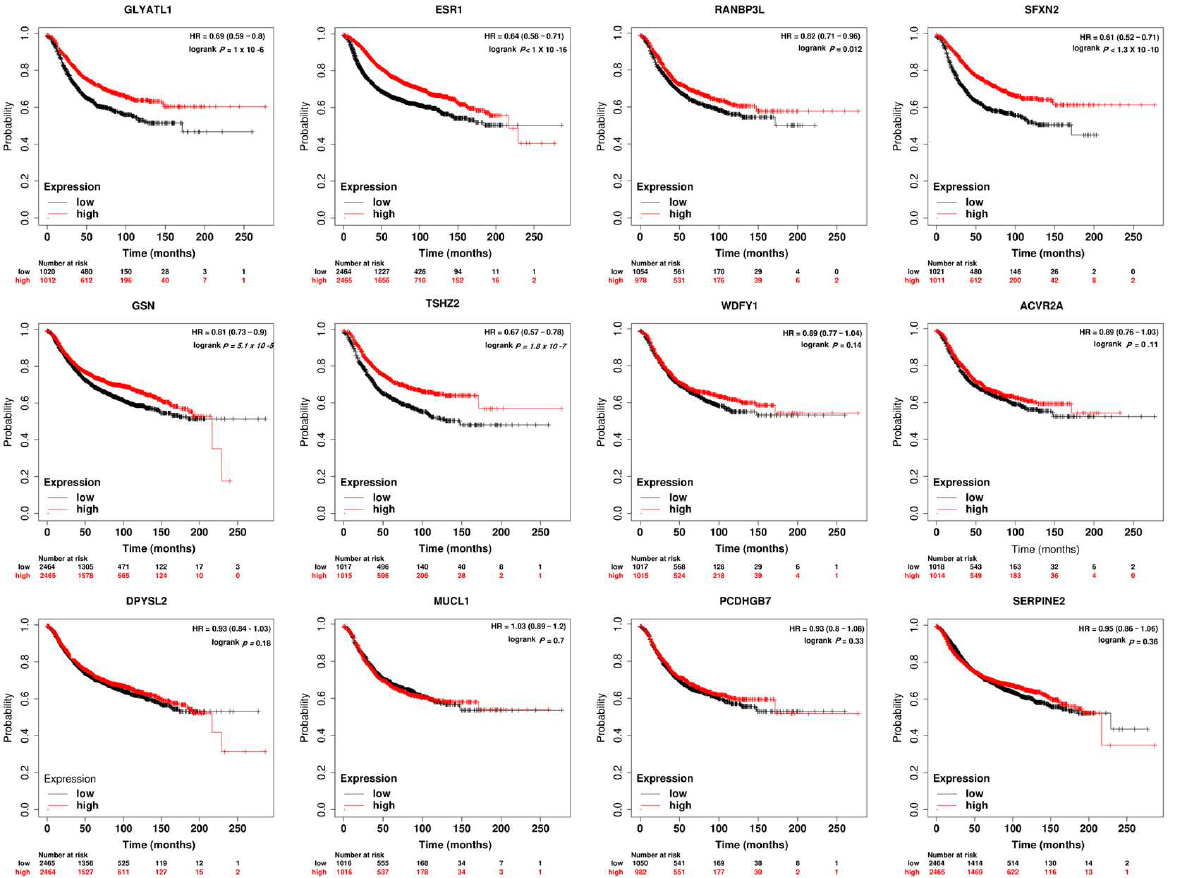
Figure 3. Prognostic Significance of the differentially expressed genes by ER-positive young-age breast cancer. Lower expression of RANBP3L , GLYATL1 , ESR1 , and SFXN2 were significantly related to shorter relapse-free survival (RFS). However, high expressions of GSN and TSHZ2 were significantly related to longer